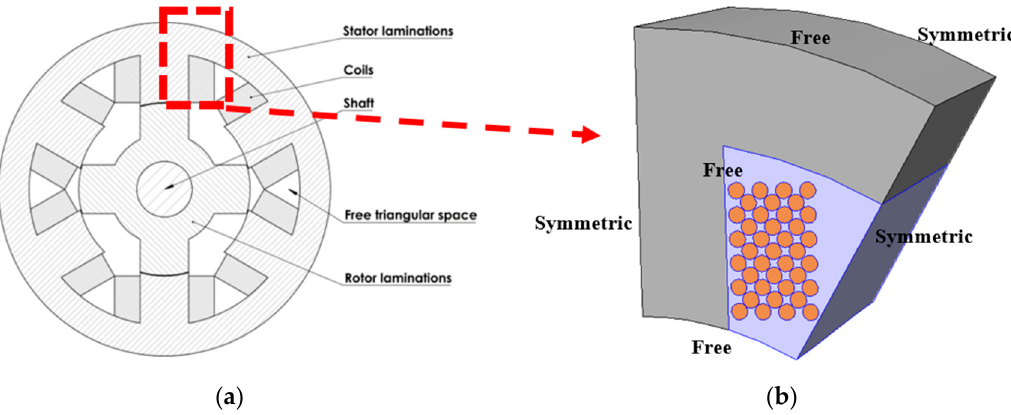
Figure 2. ( a ) 2D cross-section of an SR machine and ( b ) section of the stator with windings considered for the 3D model together with the boundary conditions used in the structural simulations. Table 1. Geometrical dimensions of the machine.